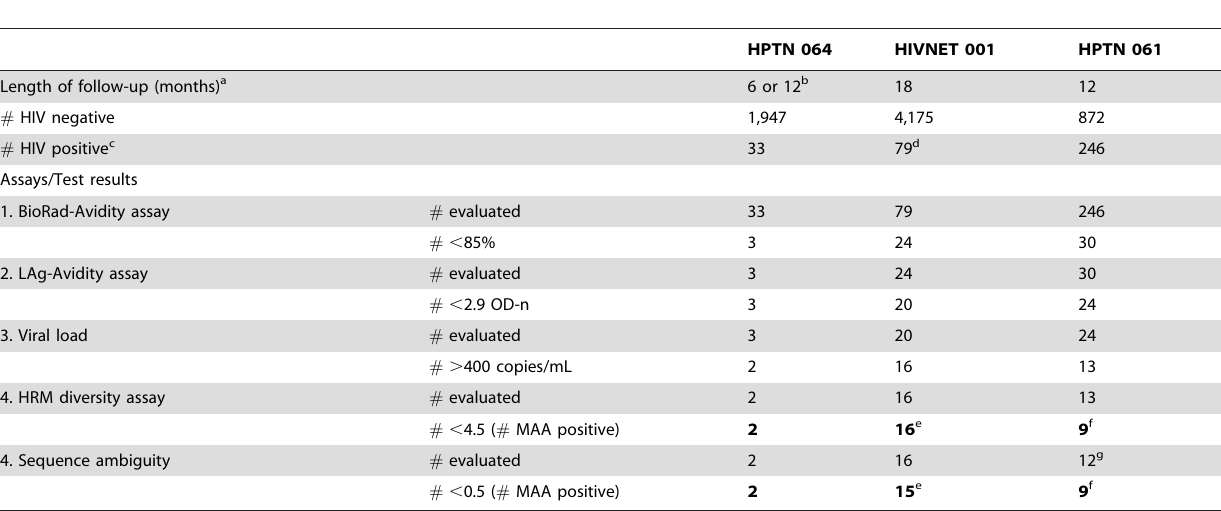
Table 1. Sample sizes used in calculating HIV incidence estimates for three clinical cohorts in the United States with two 4-assay